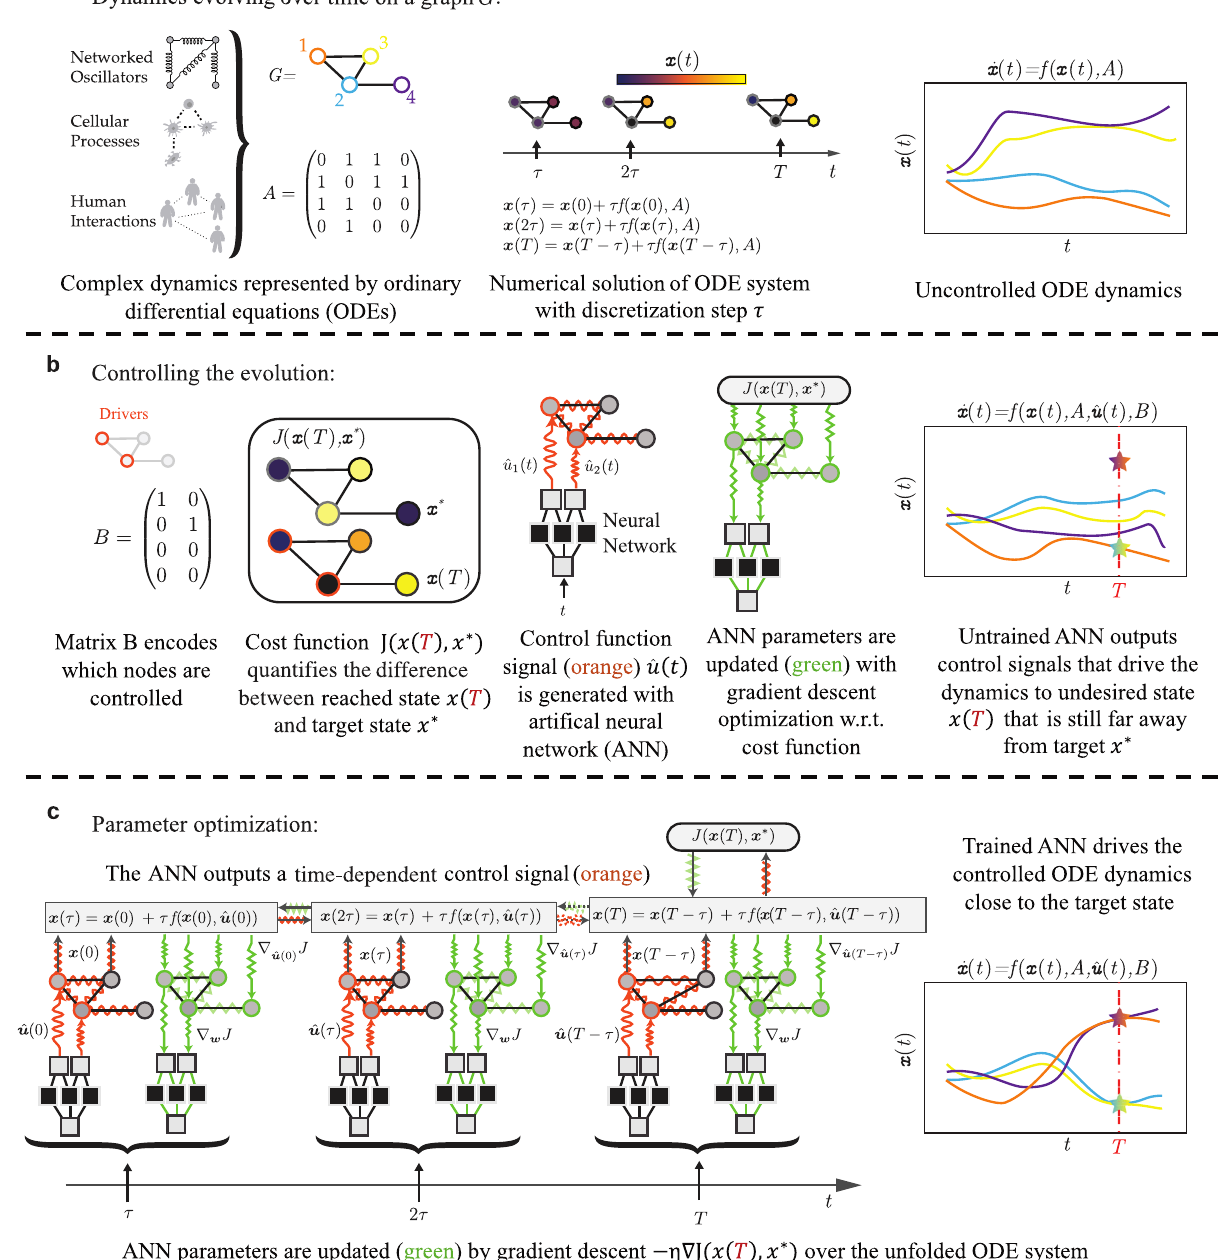
Fig. 1 Overview of AI Pontryagin. a Illustration of a complex, uncontrolled dynamical system represented by ODEs, and discretization steps of a numerical solver. b Overview of basic elements necessary to control complex systems with ANNs. c Gradient-descent training of ANN parameters over the unfolded ODE